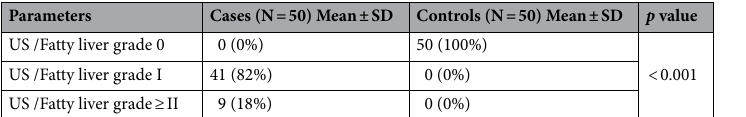
Table 2. Ultrasound characteristics of studied groups. US ultrasound.